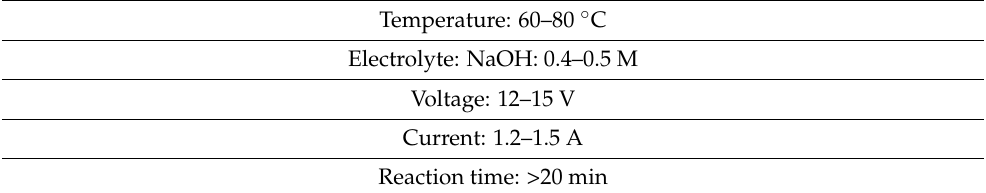
Table 2. Optimised electrolysis operation